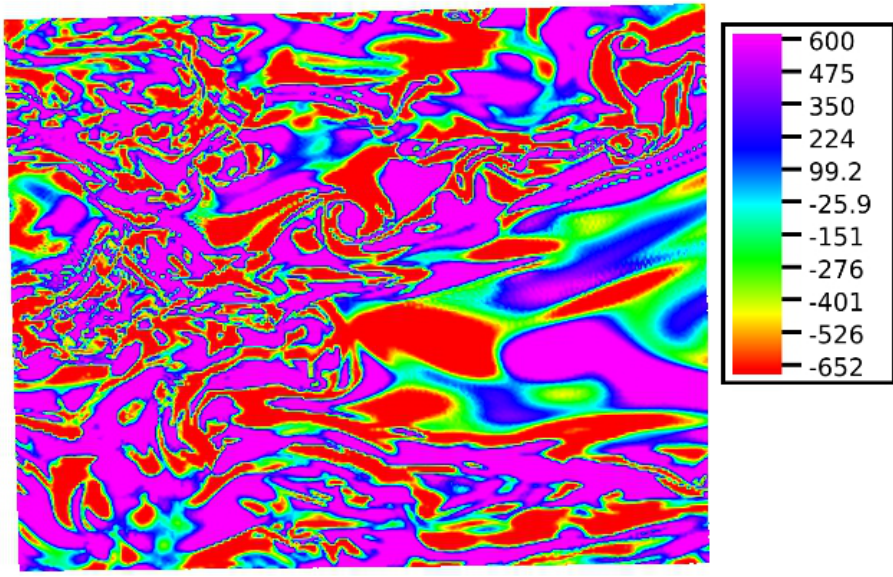
Figure 4. Visualization of potential vorticity in a small portion of the fluid for run r4k on a grid of 4096 3 points. The snapshot is taken at the peak of dissipation, and the magnification is focused on several Kelvin–Helmoltz rolls close to the center and towards the right; the image is approximately 1/10th the size of the cube in the x-z directions, and 1/100th thick (40 layers) in the y direction. Note the juxtaposition of regions of strongly positive (purple) and negative (red) regions of PV.